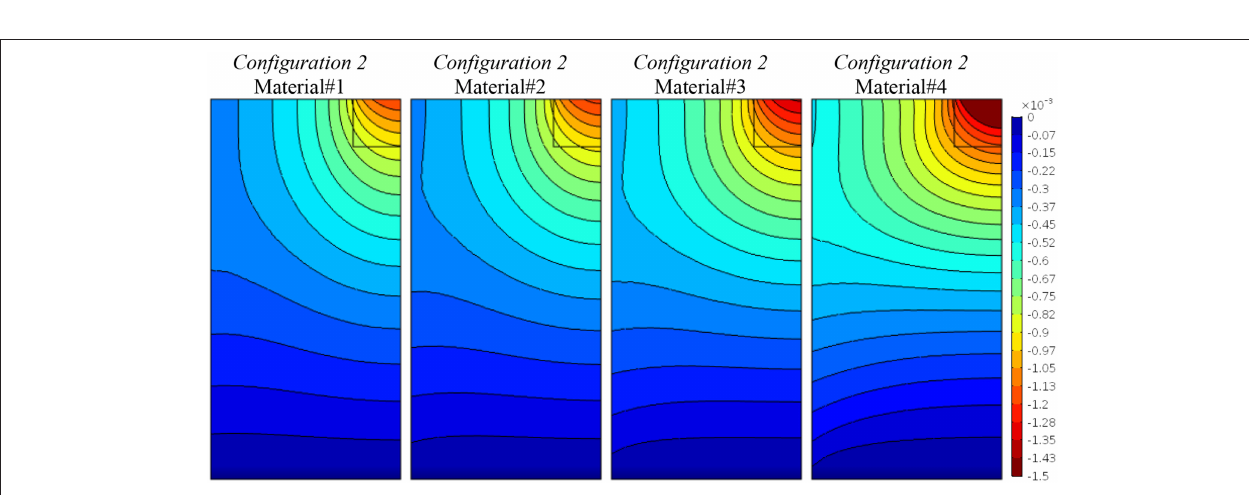
FIGURE 5 | Configuration 2, vertical displacement component, u 2 , contour plots for four material cases (Material#1/Material#4 minimum/maximum anisotropy